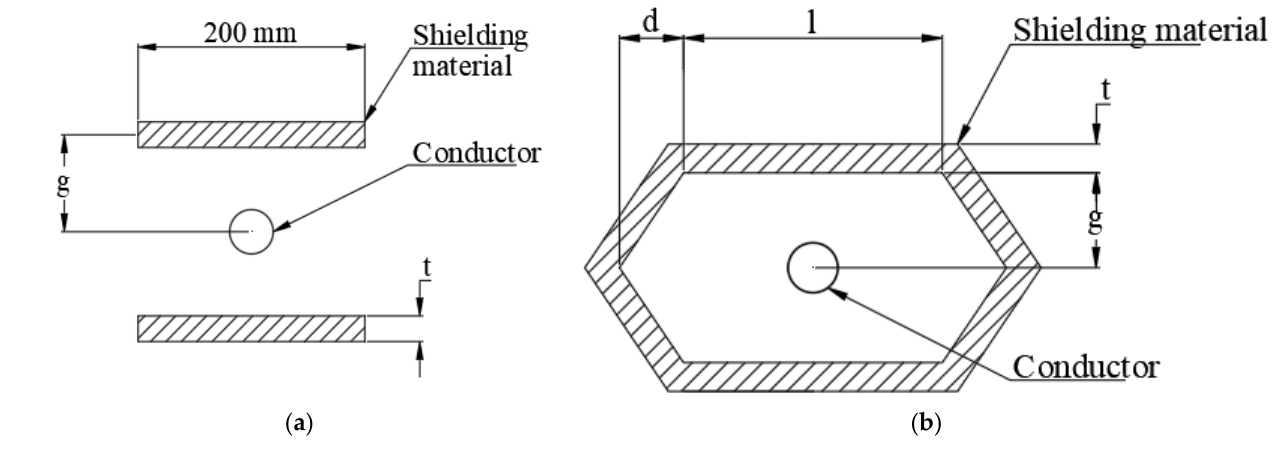
Figure 9. ( a ) Open shunting topology. ( b ) Closed shunting topology. Table 7. Details of FEA for static and high frequency